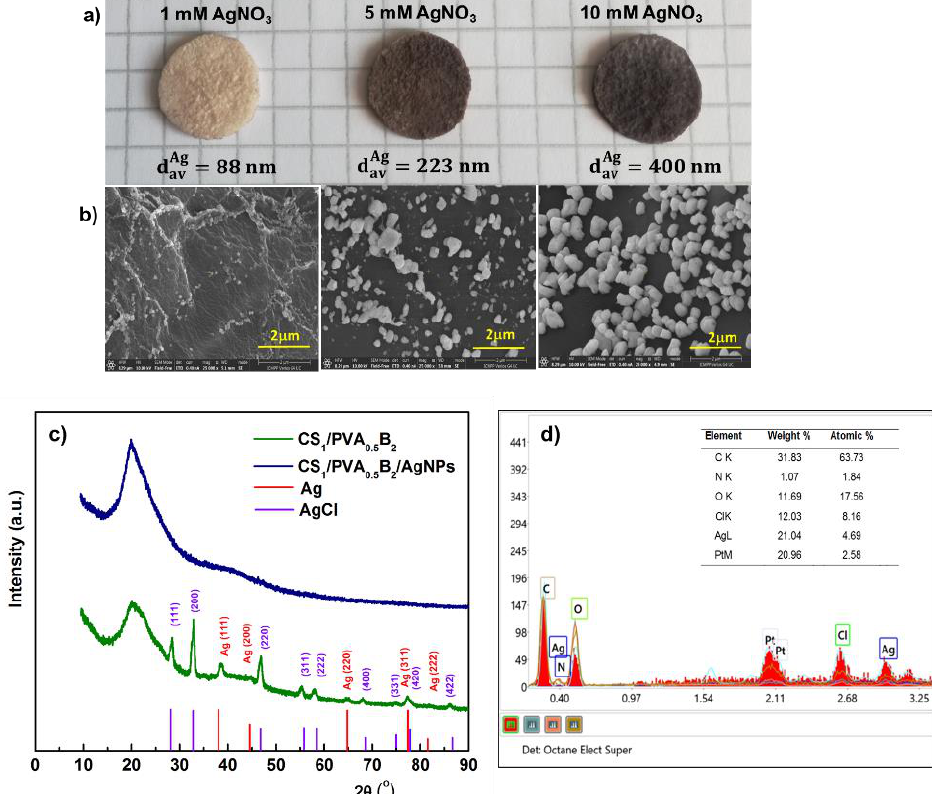
Figure 6. Optical microphotographs of CS/PVA hydrogel (sample CS 1 /PVA 0.5 B 2 ( t T = 24 h)), in situ loaded with silver nanoparticles by using different concentrations of AgNO 3 ( a ). Scanning electron micrographs (cross-sections) of the corresponding hydrogels loaded with Ag nanoparticles ( b ). XRD patterns of hydrogel without and with AgNPs after immersion in 10 mM AgNO 3 ( c ). Energy-dis- persed X-ray spectrometry (EDS) patterns of the hydrogel with AgNPs after immersion in 10 mM AgNO 3 ( d ).